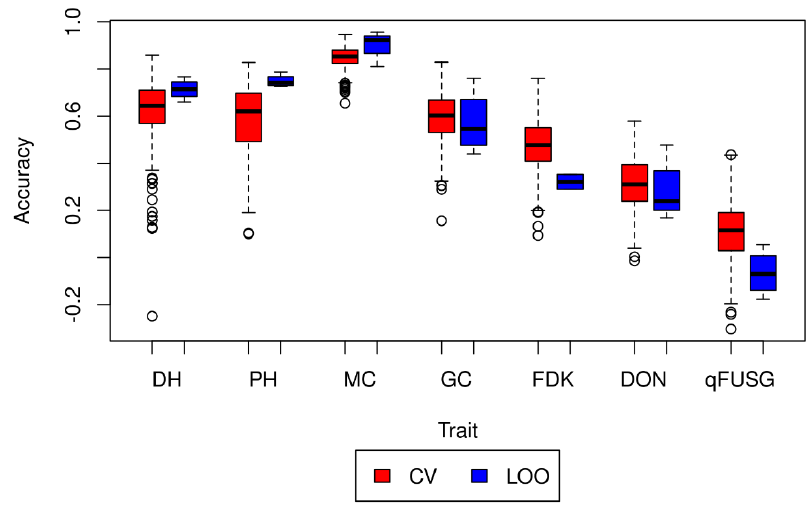
Figure 5. The validation results for the two exploited schemes, random fivefold cross-validation (red) and leave-one-out (blue). In CV, material was randomly divided into five folds and replicated for 100 times. In LOO, each trial was assigned as a validation set one at a time. Therefore, LOO boxplots include three to seven validation accuracies depending on the number of trials for each trait. The median is the line in the middle of the boxplot and the box is the interquartile range. The whiskers are 1.5 times the interquartile.